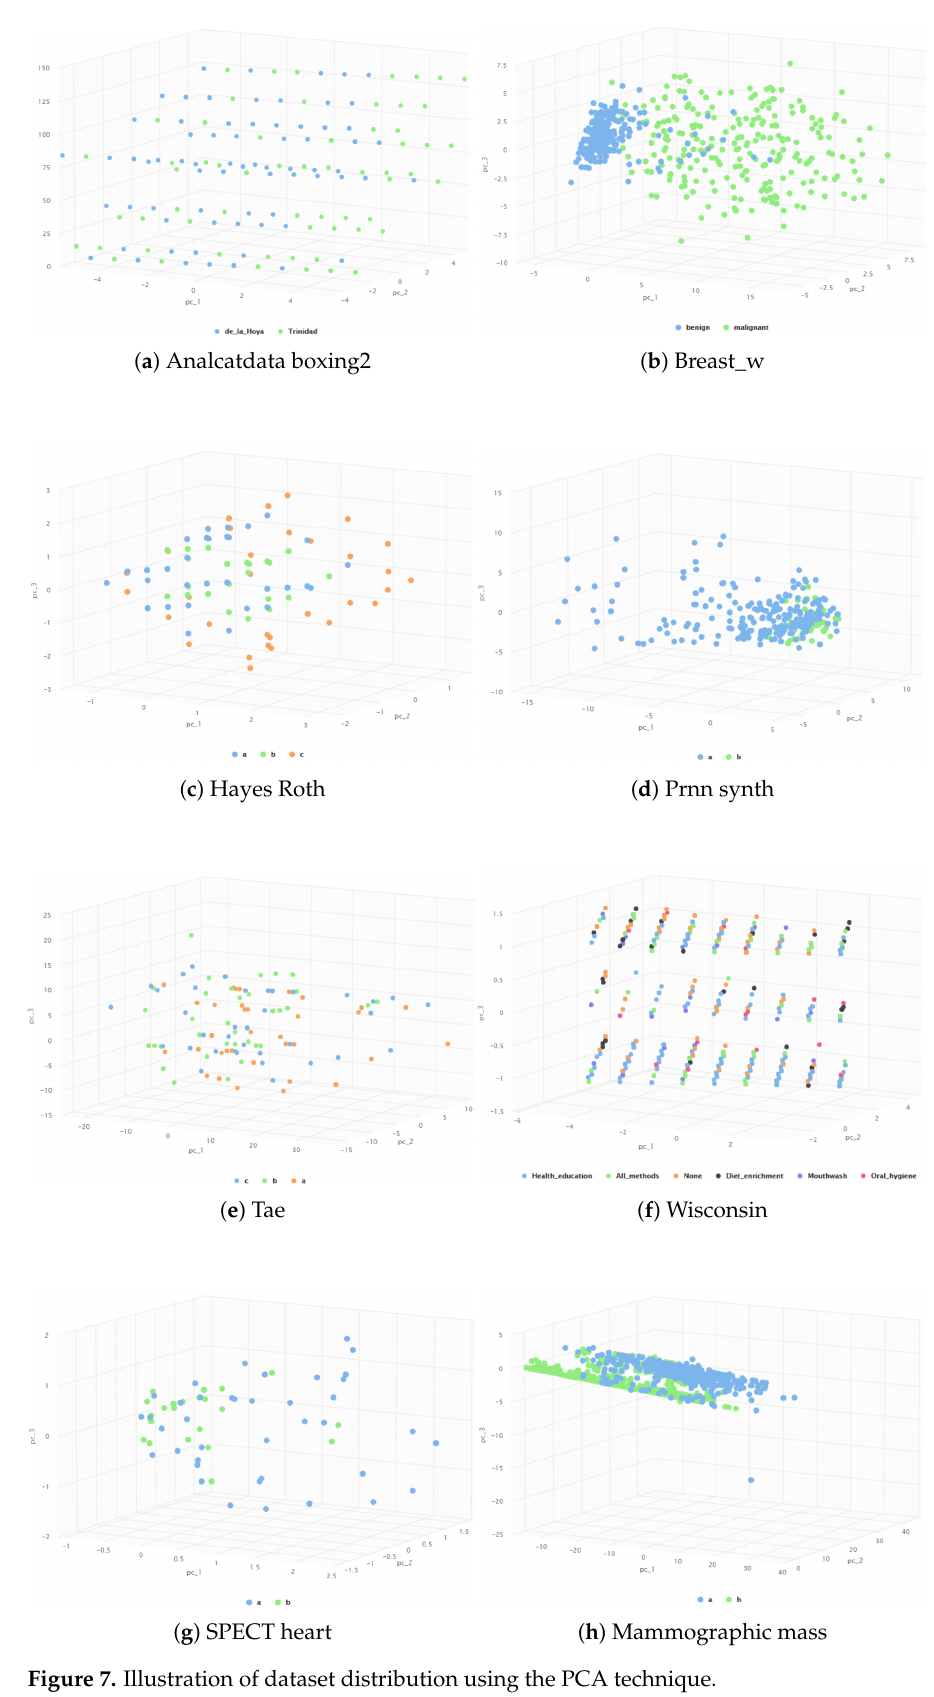
Figure 7. Illustration of dataset distribution using the PCA